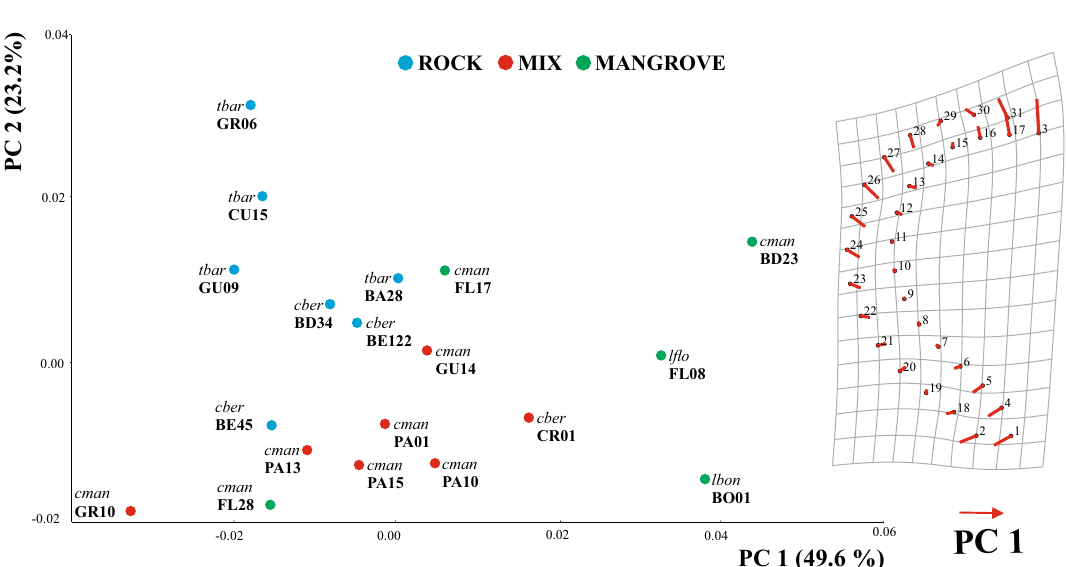
Figure 3. Claw shape in different habitats. PCA scatter plot of population mean shapes and deformation grid showing shape changes according to PC 1. Thalassozetes barbara — tbar , Carinozetes bermudensis — cber , C. mangrovi — cman , Litoribates bonairensis — lbon , L. floridae — lflo . Colors refer to ecotypes and codes refer to populations as given in Table